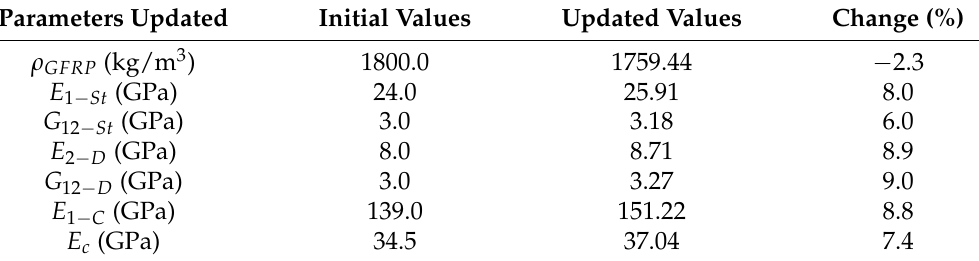
Table 6. Parameters of the FRP footbridge before and after